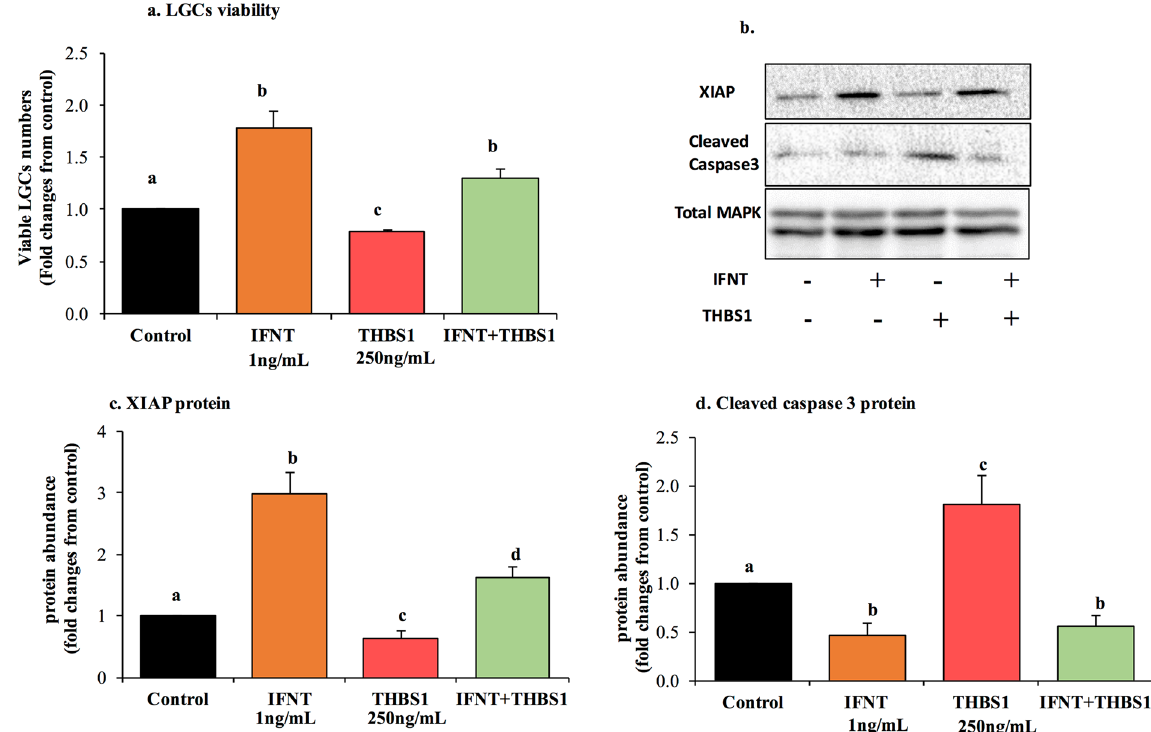
Figure 5. IFNT induces cell survival and counteracts THBS1 apoptotic actions. LGCs were treated with either with basal media (control), roIFNT (1 ng/mL), human recombinant THBS1 (250 ng/mL), or the combination of IFNT and THBS1 for 48 h. ( a ) The viable cell number, ( b ) Representative images of the western blots for each antibody, ( c ) XIAP and ( d ) cleaved caspase-3 proteins. Protein levels were determined in cell extracts by western blotting using specific antibodies and normalized relative to the abundance of total MAPK (p44/42). The results represent means ± SEM of four independent experiments. Asterisks indicate significant differences from their respective controls ( * P < 0.05, ** P < 0.01, *** P <